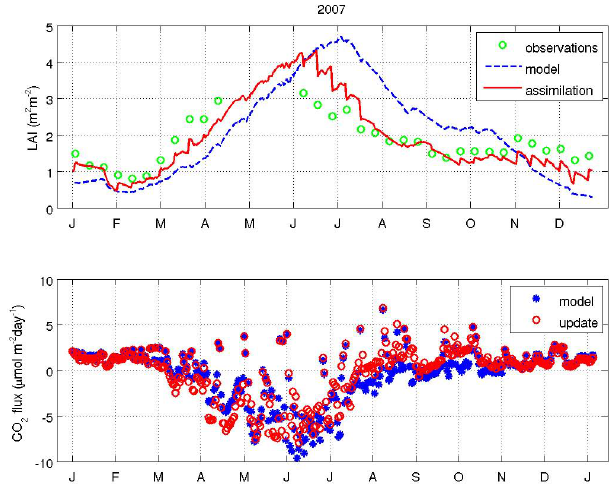
Fig. 14. Time series of observed, simulated and assimilated LAI (m 2 m − 2 ) (top) and corresponding daily evolution of simulated and updated CO 2 fluxes µmol CO 2 m − 2 s − 1 (bottom) for the year 2007 for the SMOSREX grassland